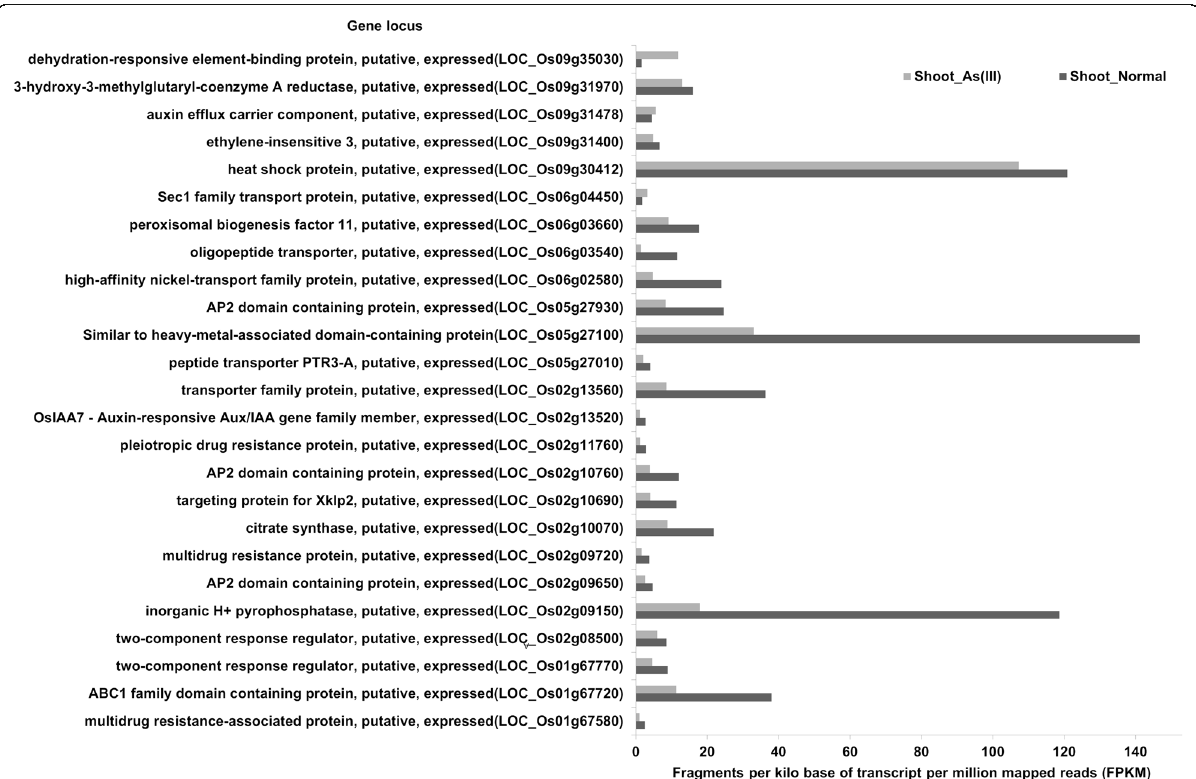
Fig. 5 Transcriptional regulation of genes contained in identified QTL regions. Only genes containing non-synonymous SNPs showing significant expression response under As (III) stress are plotted. Gene expression data adopted from Yu et al.